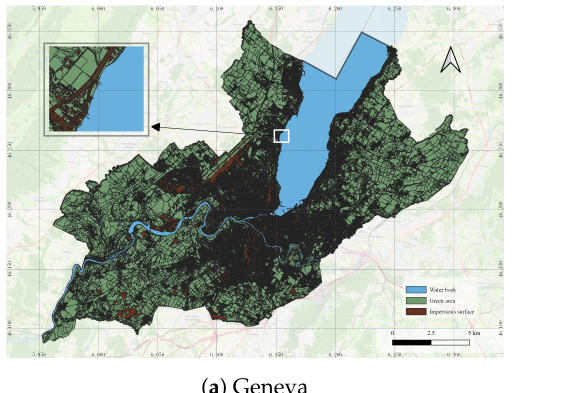
Figure 2. Land cover data.